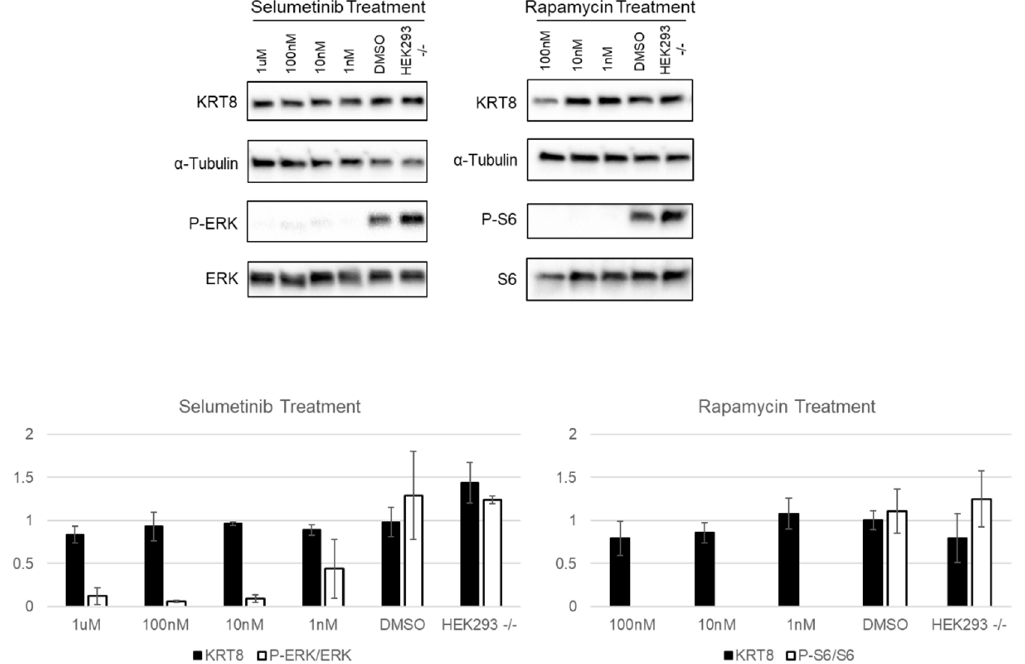
Figure 4. Keratin expression is unaffected by inhibition of Ras signaling pathways. NF1 null HEK293 cells were treated in dose response indicated with selumetinib or rapamycin and KRT8 levels (first row of bands) were evaluated by Western blot and normalized by α -tubulin (second row of bands). p-ERK/ERK ratios were also evaluated in response to selumetinib and pS6/S6 ratios in response to rapamycin to show drug efficacy (third and fourth rows of bands). Blots show an individual representative experiment. There is no statistical difference in KRT8 levels after N ≥ 3 represented in the histogram below the blots. p-ERK/ERK and pS6/S6 respond positively to selumetinib and rapamycin, respectively. Black bars indicate KRT8/tubulin ratios after treatment and white bars represent p-ERK/ERK or pS6/S6 ratios after treatment. (Rapamycin is toxic at doses higher than 100 nM). Error bars represent SEM.